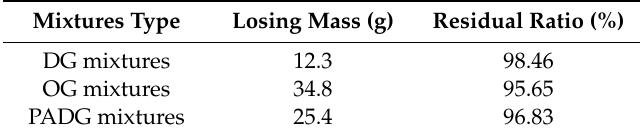
Table 2. Results of cohesion